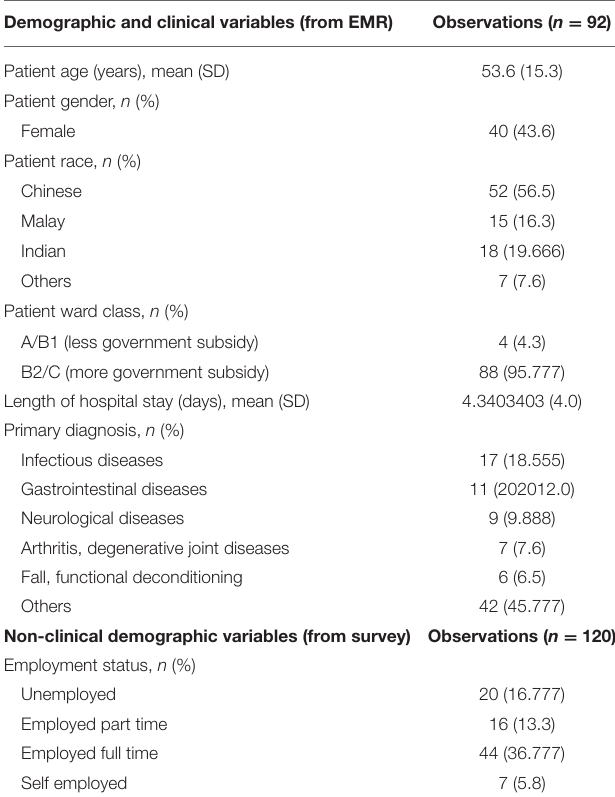
TABLE 1 | Demographic and clinical characteristics of patients